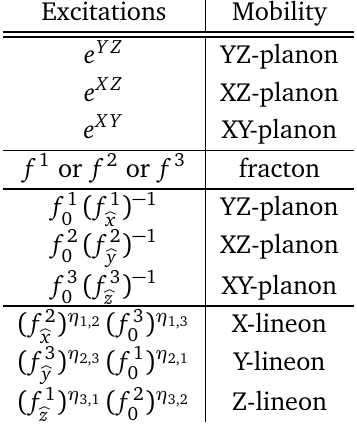
Table 1: Excitations of Figure 3 for p